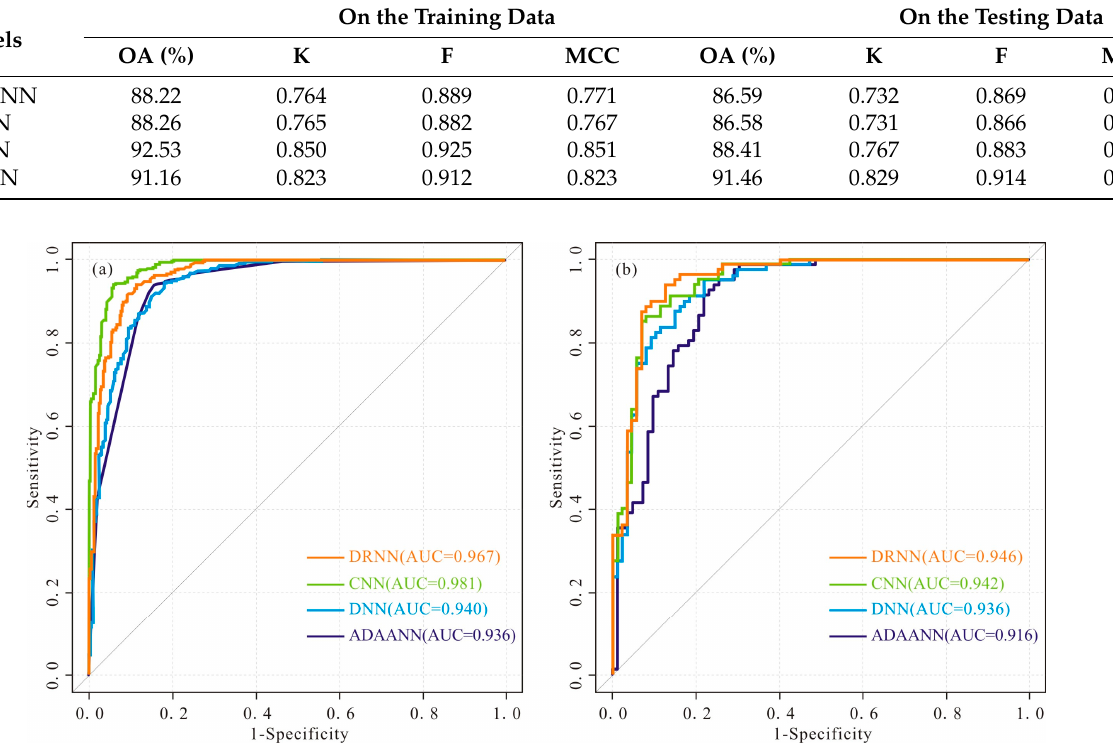
Figure 8. ROC curves of different neural network models ( a ) on the training dataset, ( b ) on the validation dataset.